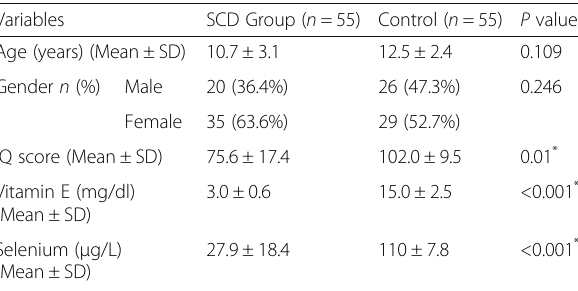
Table 2 Demographic data, antioxidant vitamins and IQ (Stanford Binet) of the study population